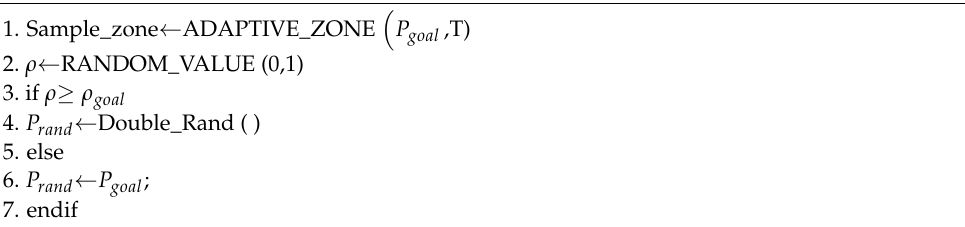
Algorithm 4: Adaptive Improved RRT EFFECTIVE_RANDOM_STATE (